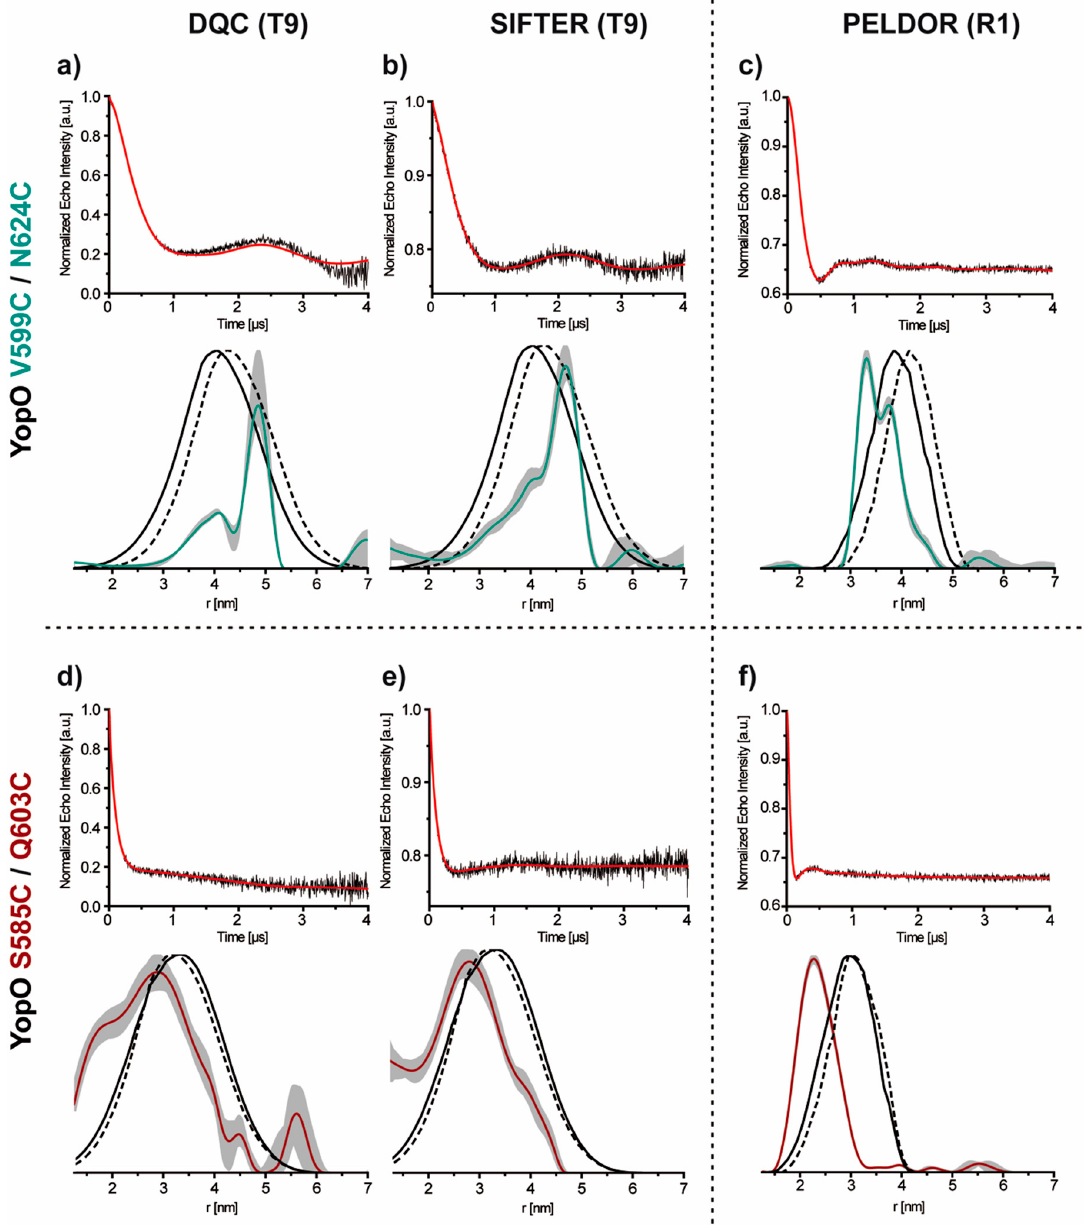
Figure 7. The PDS data of YopO V599C/N624C and S585C/Q603C. On the left, the background corrected DQC ( a , d ) and SIFTER ( b , e ) time traces (top) and their corresponding distance distributions (bottom) for YopO V599 T9 /N624 T9 and S585 T9 /Q603 T9 . On the right, the PELDOR ( c , f ) time traces (top) and the corresponding distance distributions (below) for YopO V599 R1 /N624 R1 (mint) and S585 R1 /Q603 R1 (red). In each case, the background corrected PDS time traces are shown in black, the corresponding fits from Tikhonov regularization in red. The distance distributions are shown in the respective color code while shaded grey areas indicate the error margins as obtained by the validation routine of DeerAnalysis [78]. The in silico predictions of the distance distributions were generated with mtsslWizard [75] and overlaid as dashed (PDB-ID 4ci6) and solid (PDB-ID 2h7o) black lines.